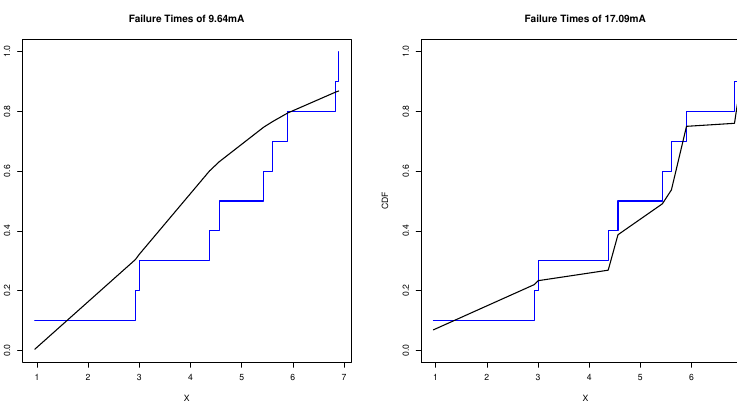
Figure 12. The empirical and estimated CDFs of the EBuH distribution for the two stress